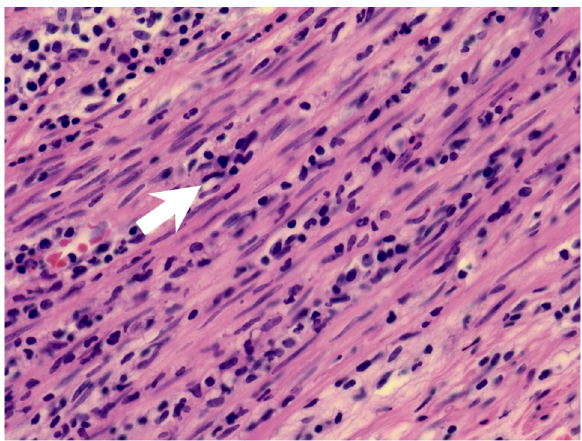
Figure 1. Bilateral bulbar non-exudative conjunctival injection, swelling, and erythematous change of fingers and soles.